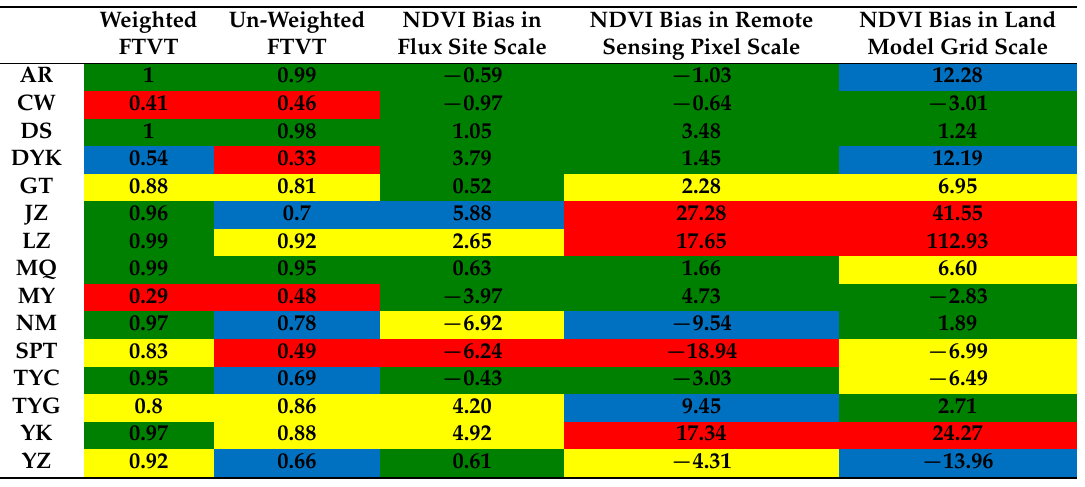
Table 3. Spatial representativeness of the sites at vegetation-type level and spatial-scale level, ranked by fraction of target vegetation type (FTVT) and cluster analysis of NDVI biases (%), respectively. The color of each cell represents its grades: green cell is homogeneous measurements; yellow cell is representative measurements; blue cell is acceptable measurements; and red cell is disturbed measurements.